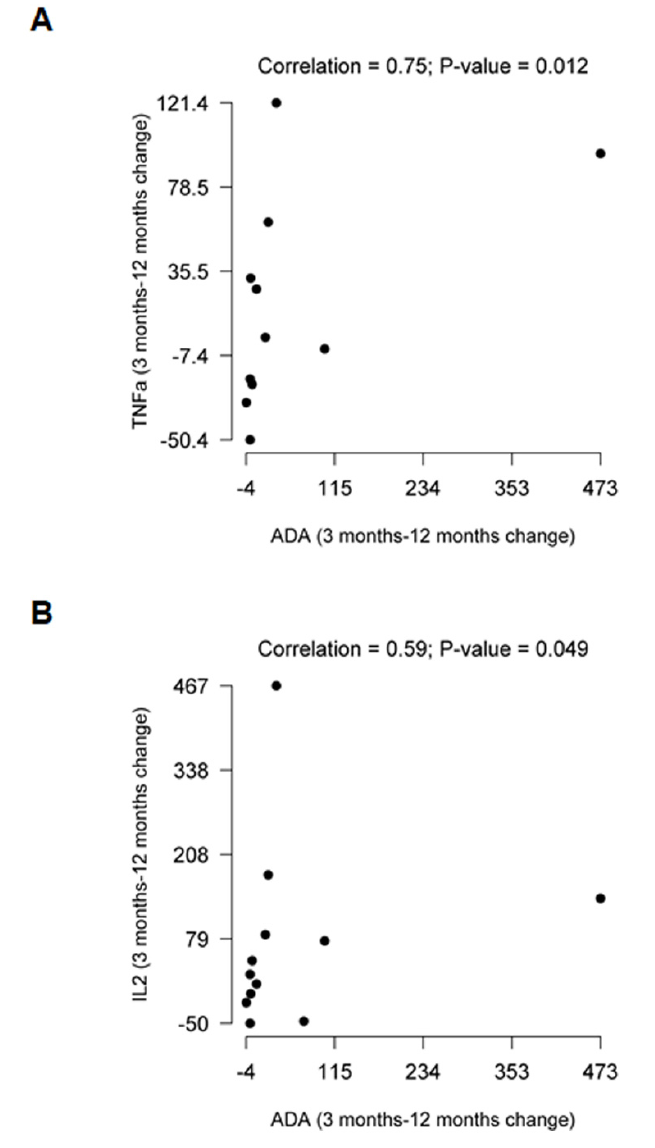
Figure 2. Association between ADA, TNF α , and IL2. ( A ) Spearman correlation between ADA and TNF α changes at 3- and 12-months post-treatment. ( B ) Spearman correlation between ADA and IL2 changes at 3- and 12-months post-treatment.